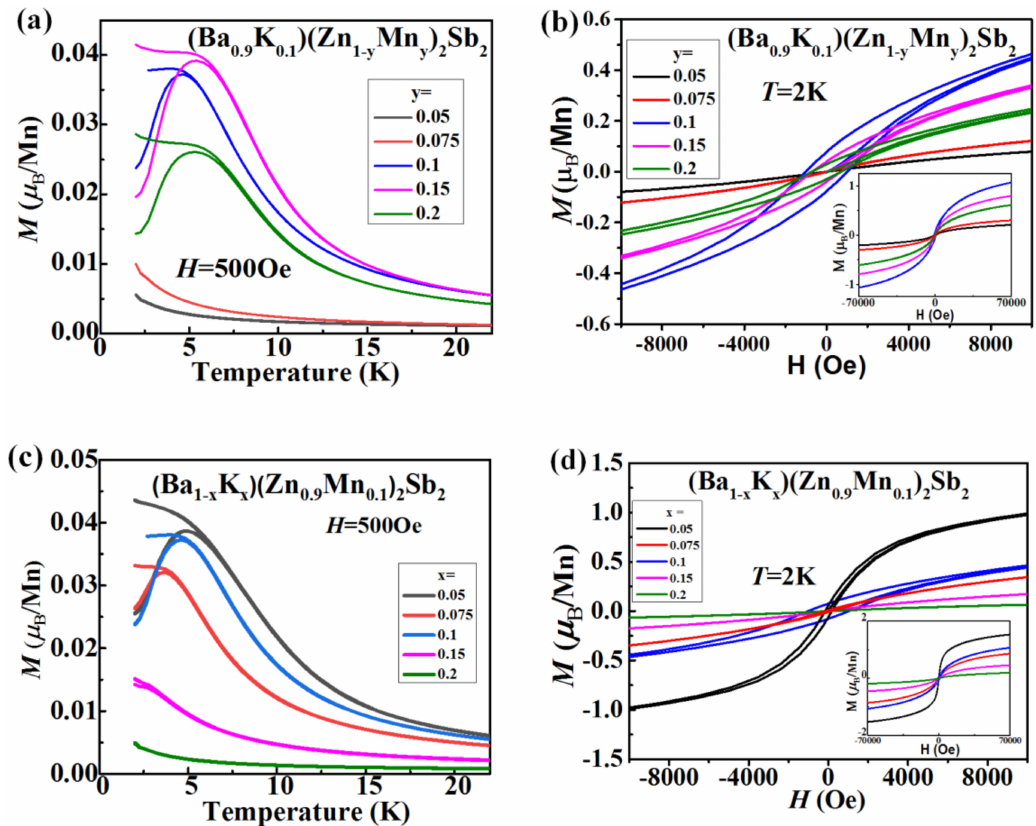
Figure 4. ( a ) DC M ( T ) measured under H = 500 Oe of (Ba 0.9 K 0.1 )(Zn 1 − y Mn y ) 2 Sb 2 (y =